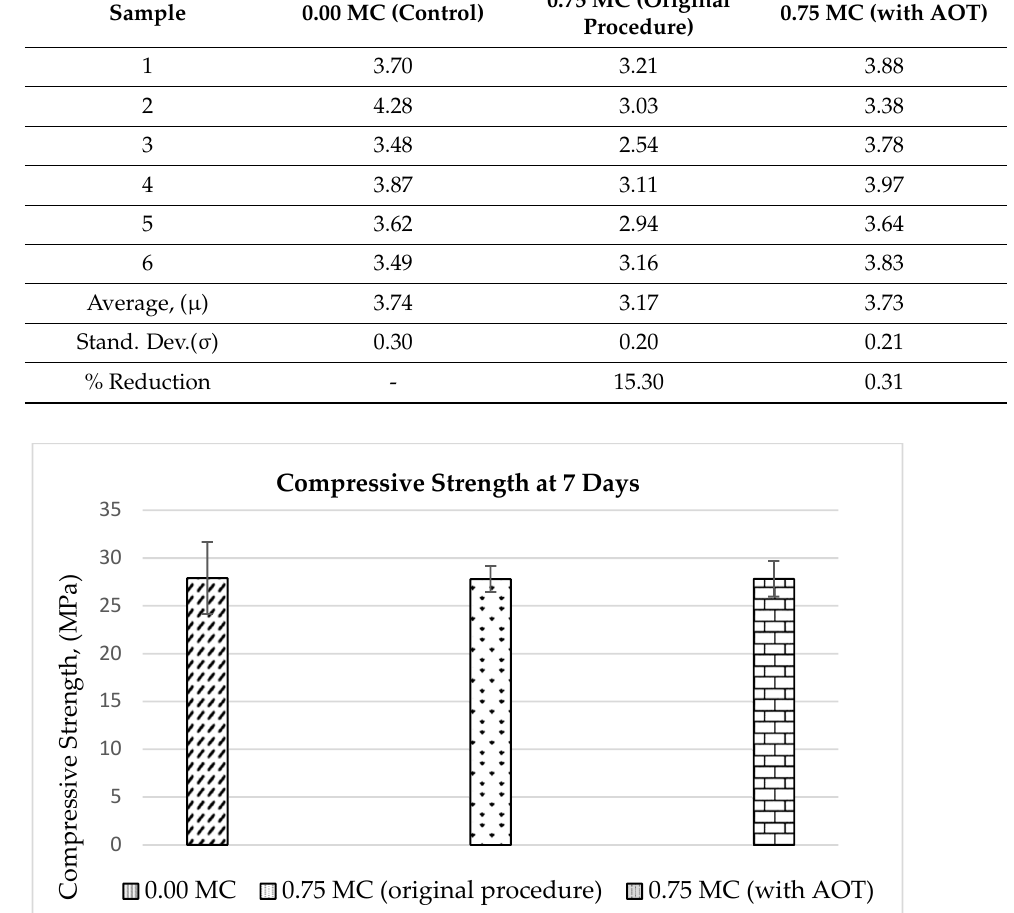
Figure 5. Mortar flexural strength versus microcapsule concentration at 7 curing days (Error bars = standard deviation).